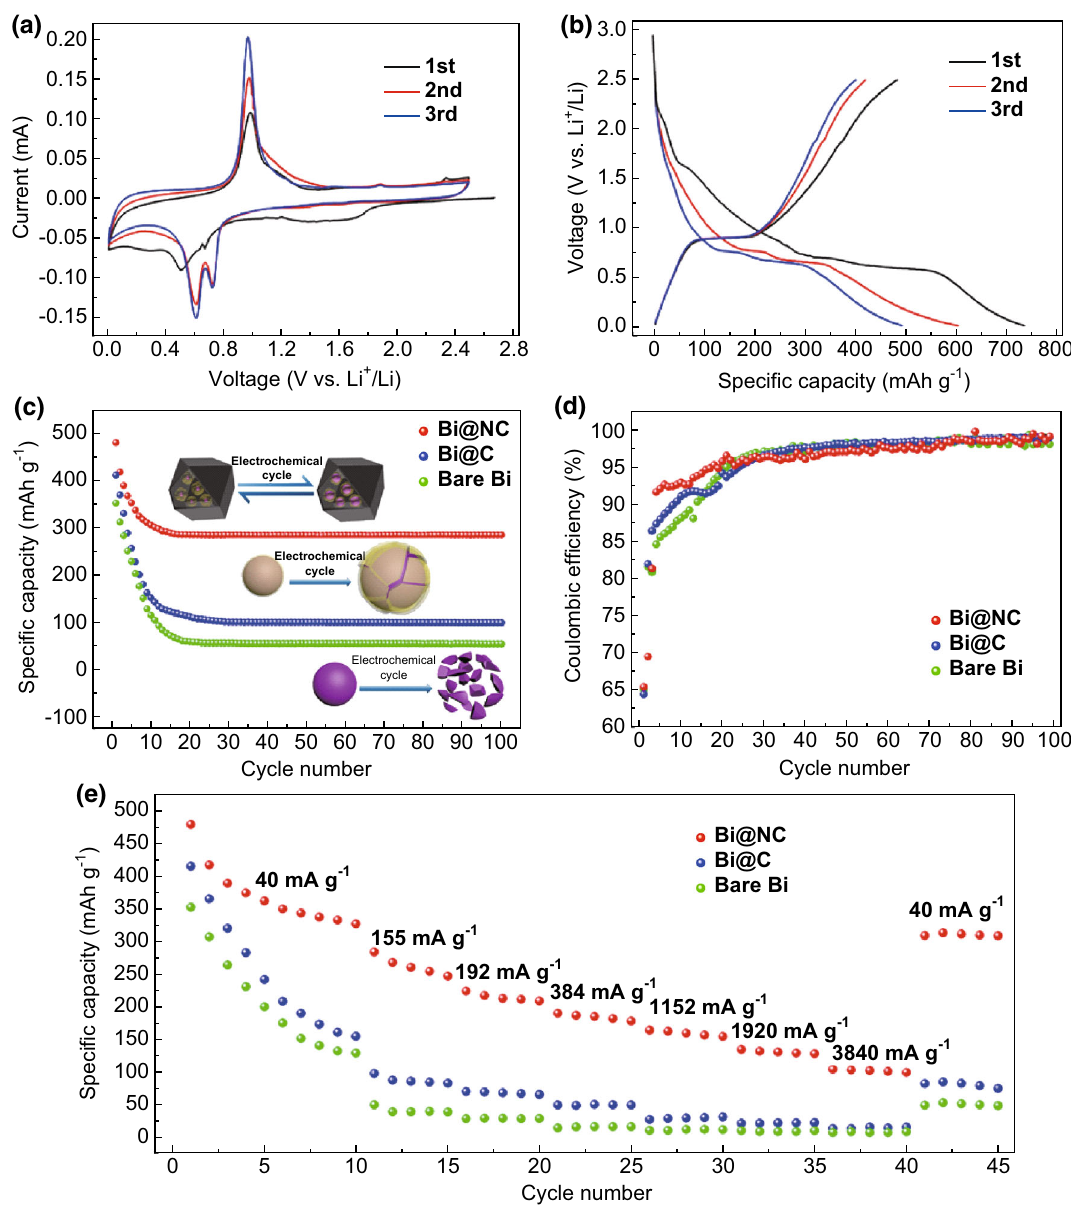
Fig. 6 a Cyclic voltammograms and b charge–discharge curves of Bi@NC; comparisons of c cyclic stability, d coulombic efficiency, and e rate capabilities of Bi@NC, Bi@C, and bare